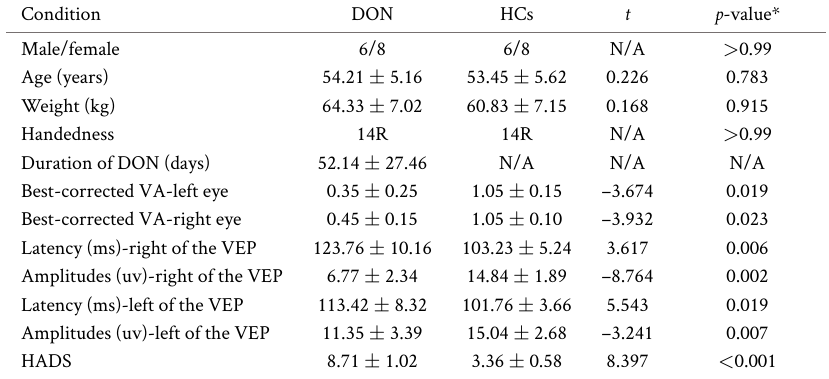
Table 1. Basic information of participants in the study.